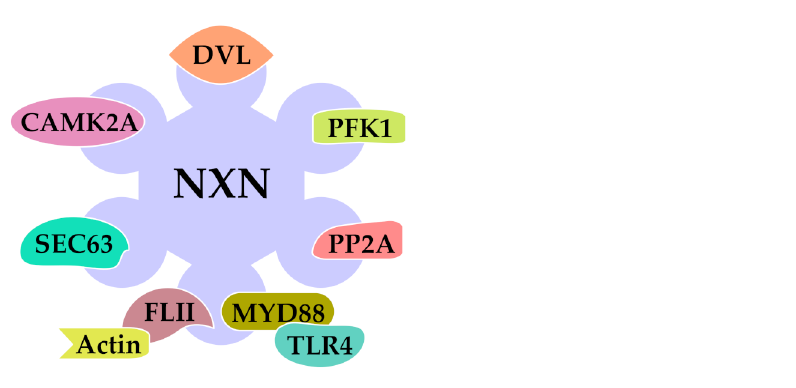
Figure 1. Schematic representation of NXN redox-sensitive interactions. NXN directly interacts with several proteins, including DVL, PFK1, PP2A, MYD88, FLII, SEC63 and CAMK2A, which participate in the regulation of the activity of different signaling pathways. Since only some interaction domains between NXN and DVL, PP2A and SEC63 have been described so far, the image shows a hypothetical representation of the NXN-protein interactions. The interaction domains already characterized are described